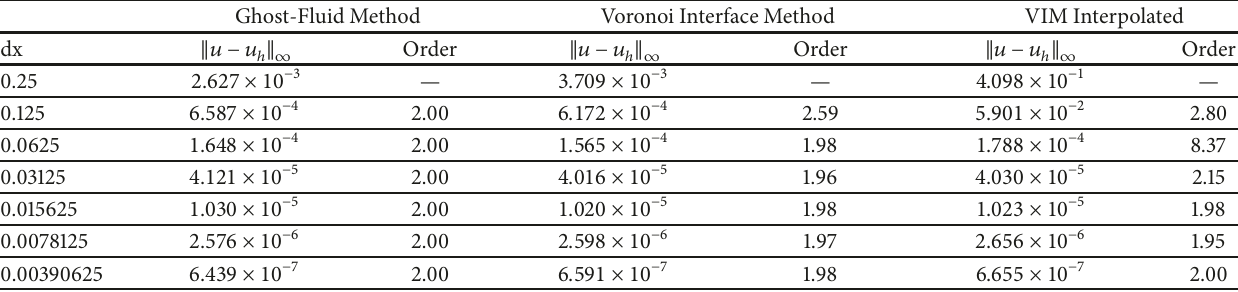
Figure 1: Left: visualization of the exact solution, for example, shown in Section 3.1. Right: example of a Voronoi mesh generated. Table 1: Comparison of the 𝐿 ∞ error in the solution for the Ghost-Fluid Method and the Voronoi Interface Method, for example, shown in Section 3.1.